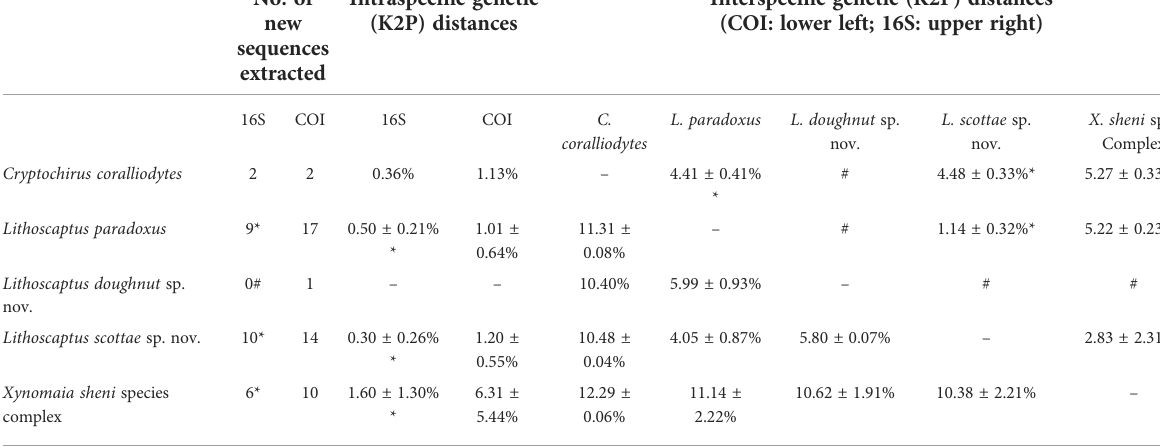
broad; carpus and propodus elongated, subequal in length (Figure 8M); dactylus slender and elongated, curving and articulating ventrally (Figure 8N). Thoracic sternite anteriorly extending between bases of both Mxp3; anterior plate rhomboid, approximately as long as broad, anteriorly rimmed, medially depressed, surface granular; constriction narrow, less than 1/2 of width of anterior plate, much depressed, grooved along mid-line, con fl uent with depression along midline; sternites 5 and 6 medially not separated, much depressed along midline; gonopore on sternite 6 as a fi ne slit, oriented obliquely, opening much sheltered from ventral view by a narrow lateral eave-like extension; suture 6/7 medially nearly con fl uent, separated medially; sternite 7 median line well de fi ned; suture 7/8 medially separated (Figure 8H). Plp1 and Plp2 biramous, Plp3 uniramous. TABLE 2 Query and reference sequences examined in the present study. No. of Intraspeci fi c genetic Interspeci fi c genetic (K2P) distances new (K2P) distances (COI: lower left; 16S: upper sequences extracted